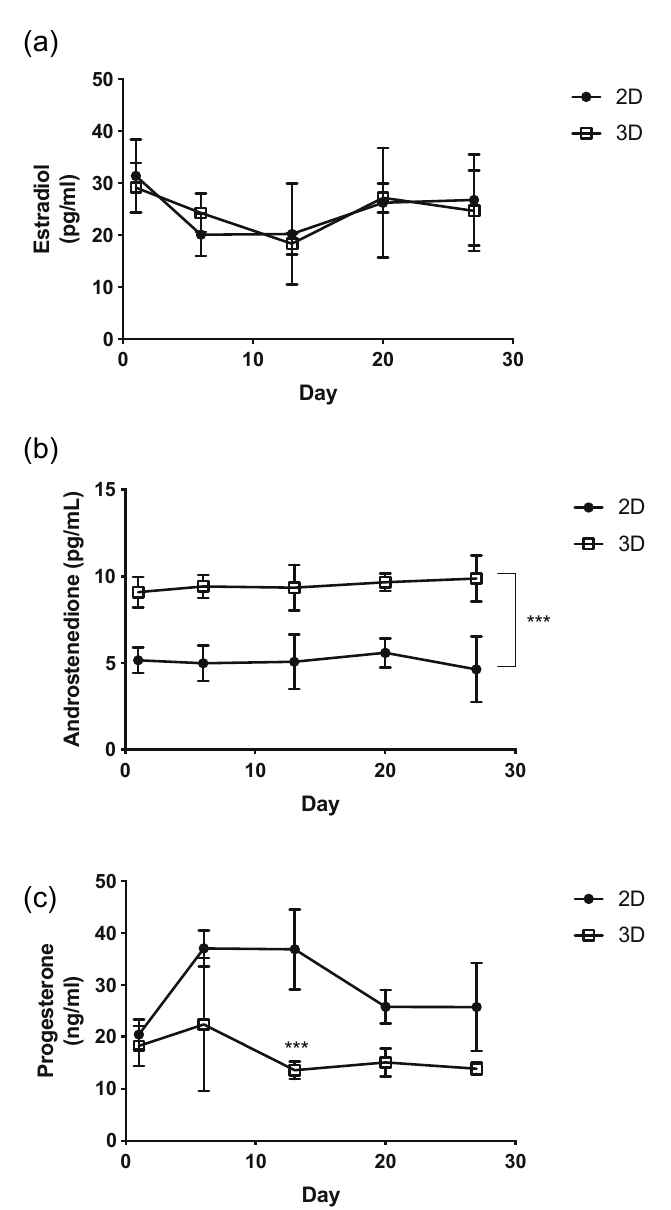
Figure 5. Hormone level as a function of time by co-cultured granulosa cells with theca cells in a 2D and 3D system. ( a ) Estradiol, ( b ) Androstenedione, ( c ) Progesterone. The figures represent data from three separate experiments.